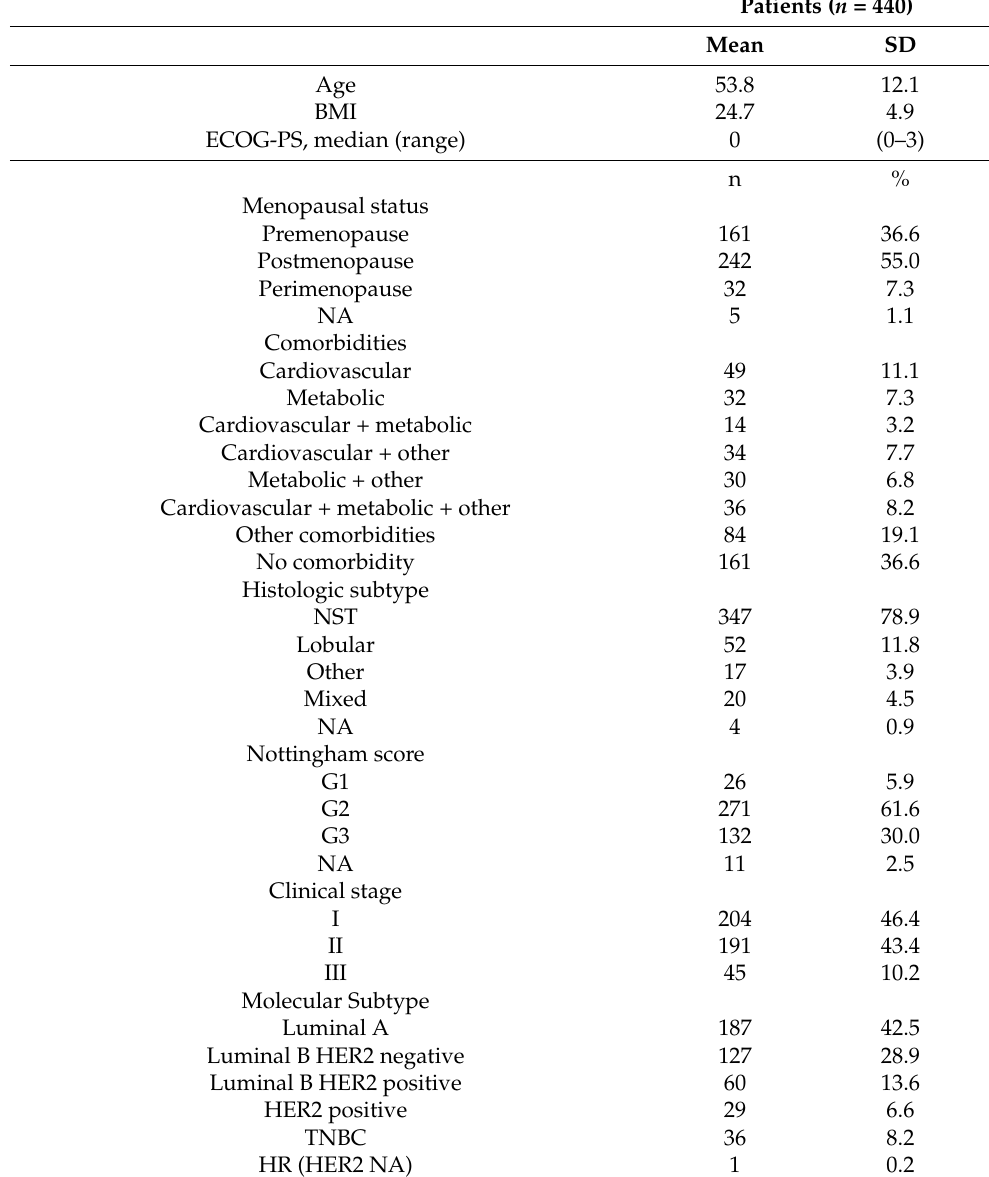
Table 1. Demographic, clinical, and pathological characteristics of BC